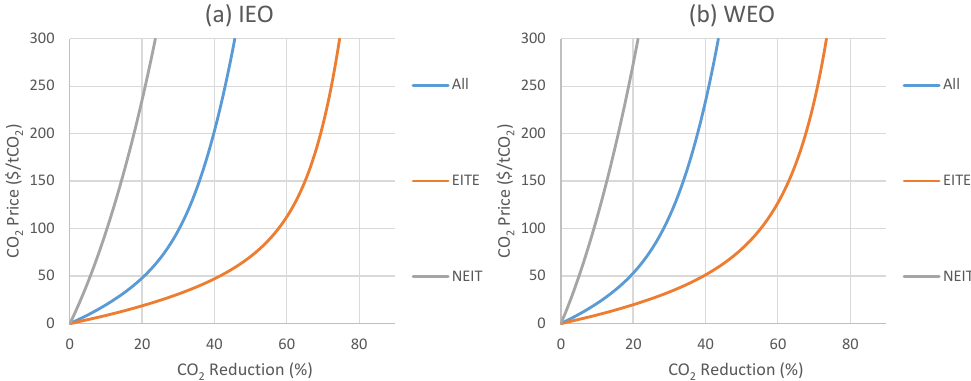
Figure 5. EITE, NEIT, and All MACCs in percentage change in EUR in 2030 under the IEO and WEO